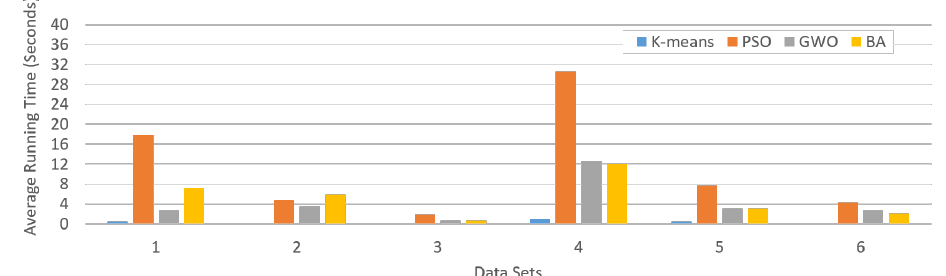
Figure 8. Average running time of SI